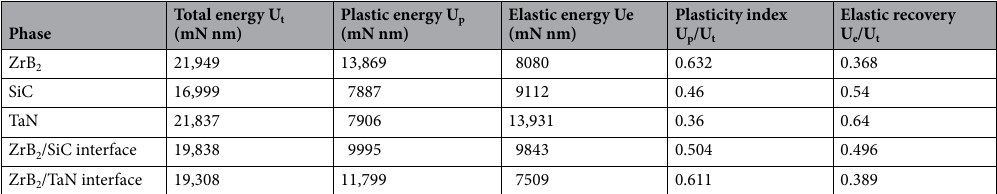
Table 2. Calculated total energy, plastic energy, elastic energy, plasticity index, and elastic recovery of different phases in ZrB 2 -SiC-TaN